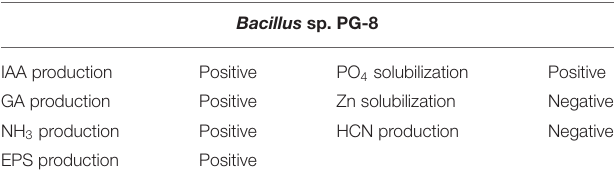
TABLE 2 | Primary screening of Bacillus sp. PG-8 for plant growth-promoting